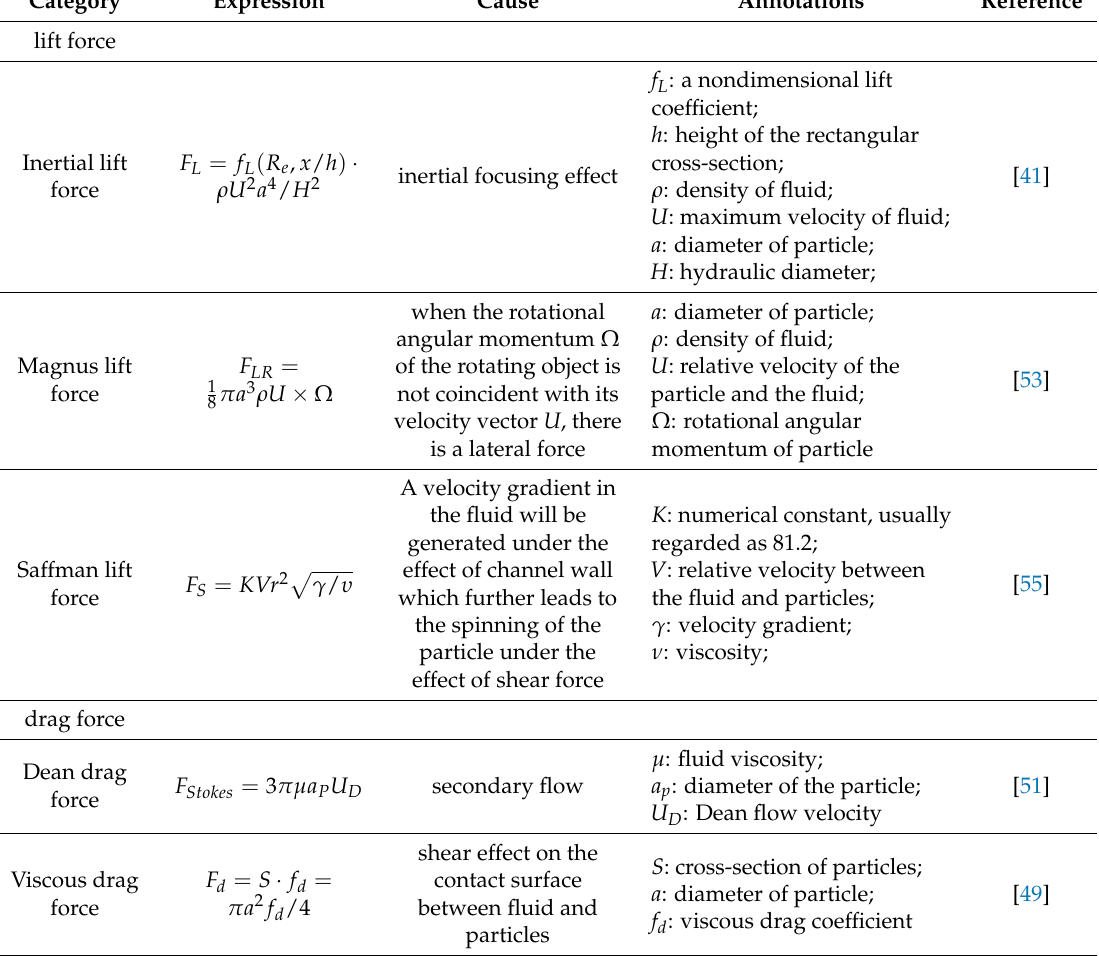
Table 1. Summary of force